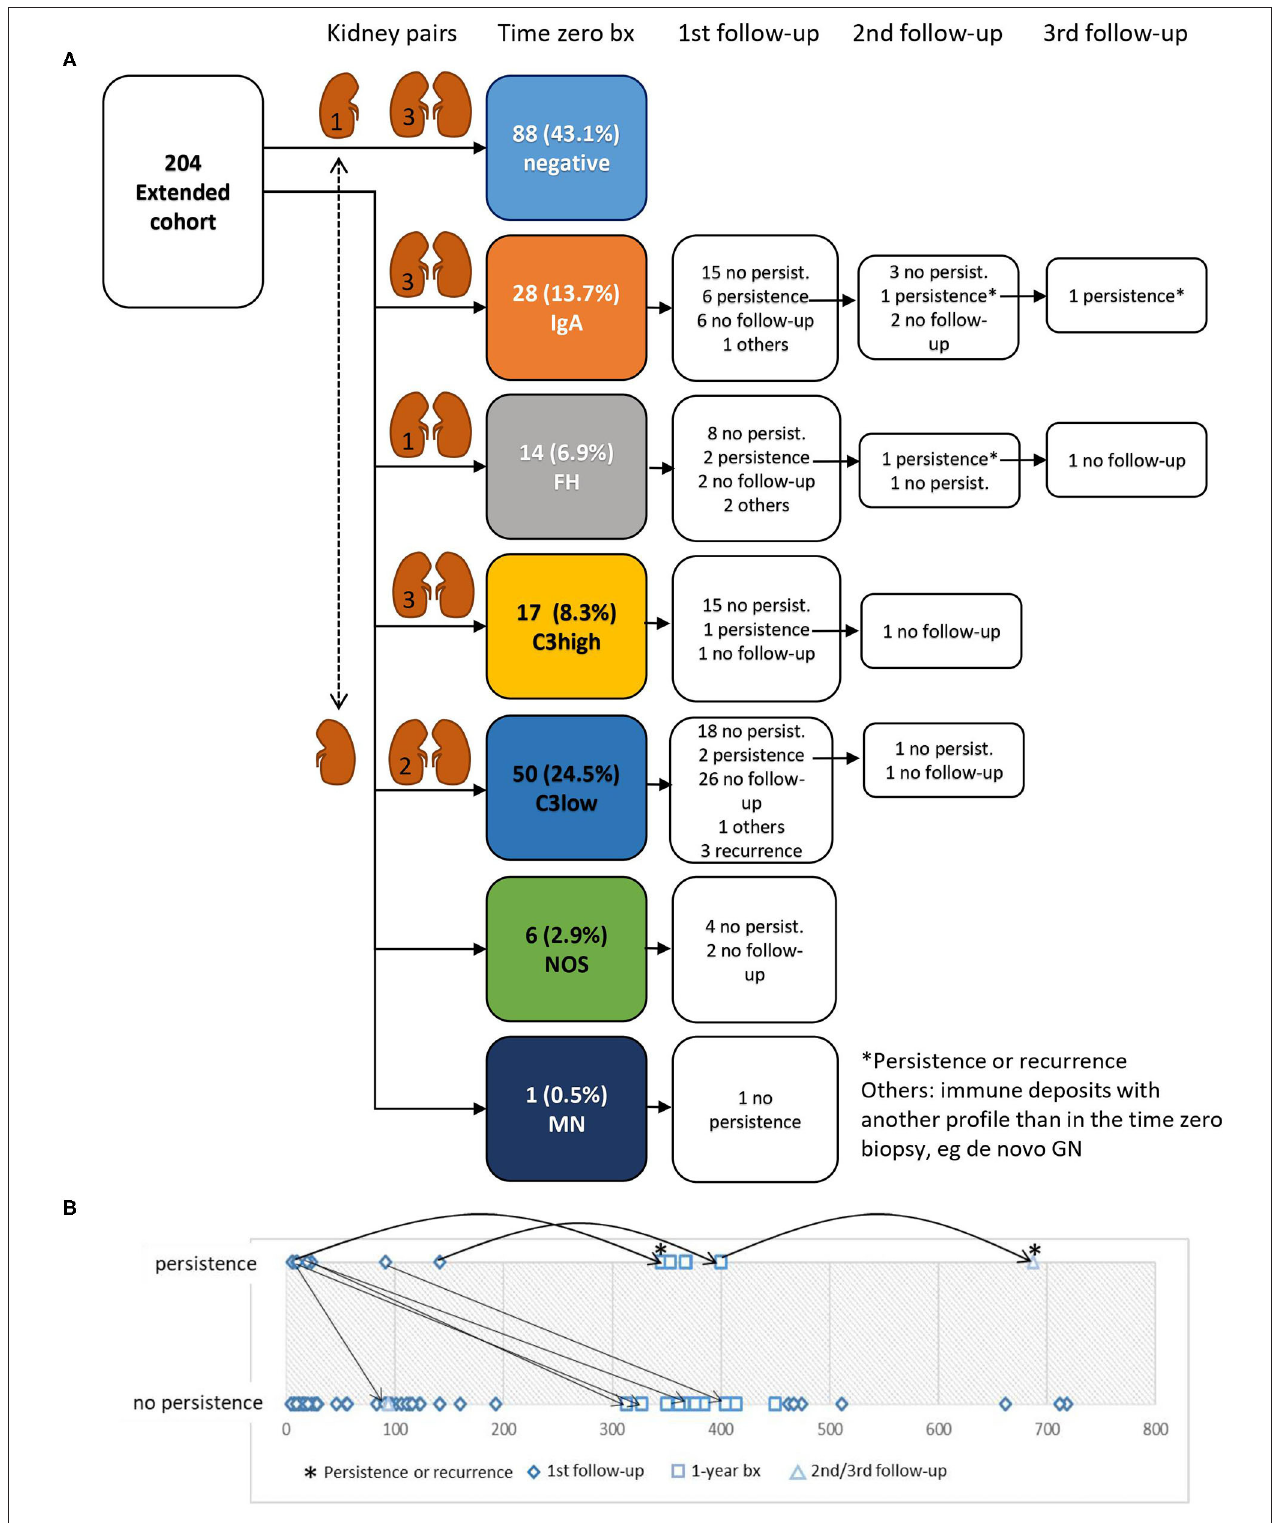
FIGURE 2 | Disappearance and persistence of immune reactivity in follow-up biopsies. (A) Of 204 specimens included in the analysis 116 showed glomerular immune reactivity exceeding the definition of negative. In 79 cases immunohistochemical follow-up analyses were performed. In the majority of cases immune reactivity